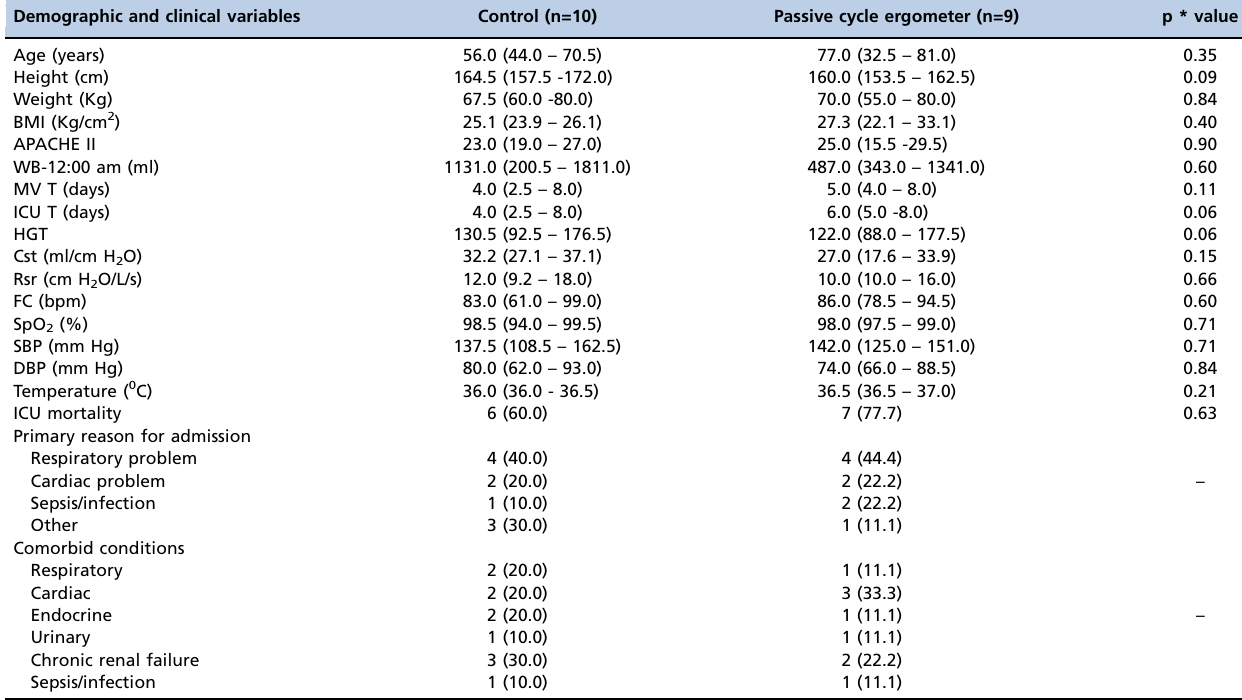
Table 1 - Comparison of demographic and clinical variables between the two groups. Demographic and clinical